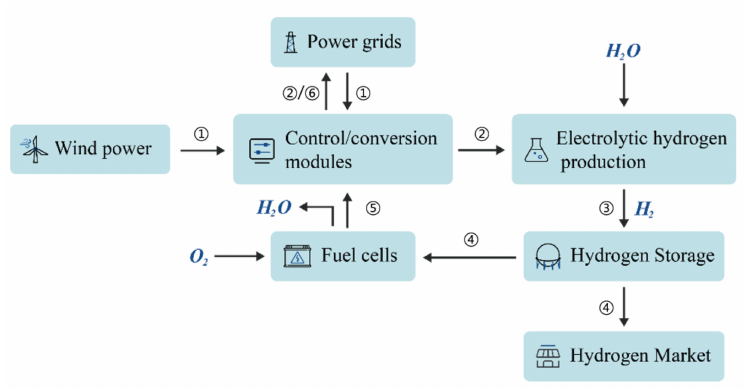
Figure 1. Structure of wind–hydrogen coupled power generation